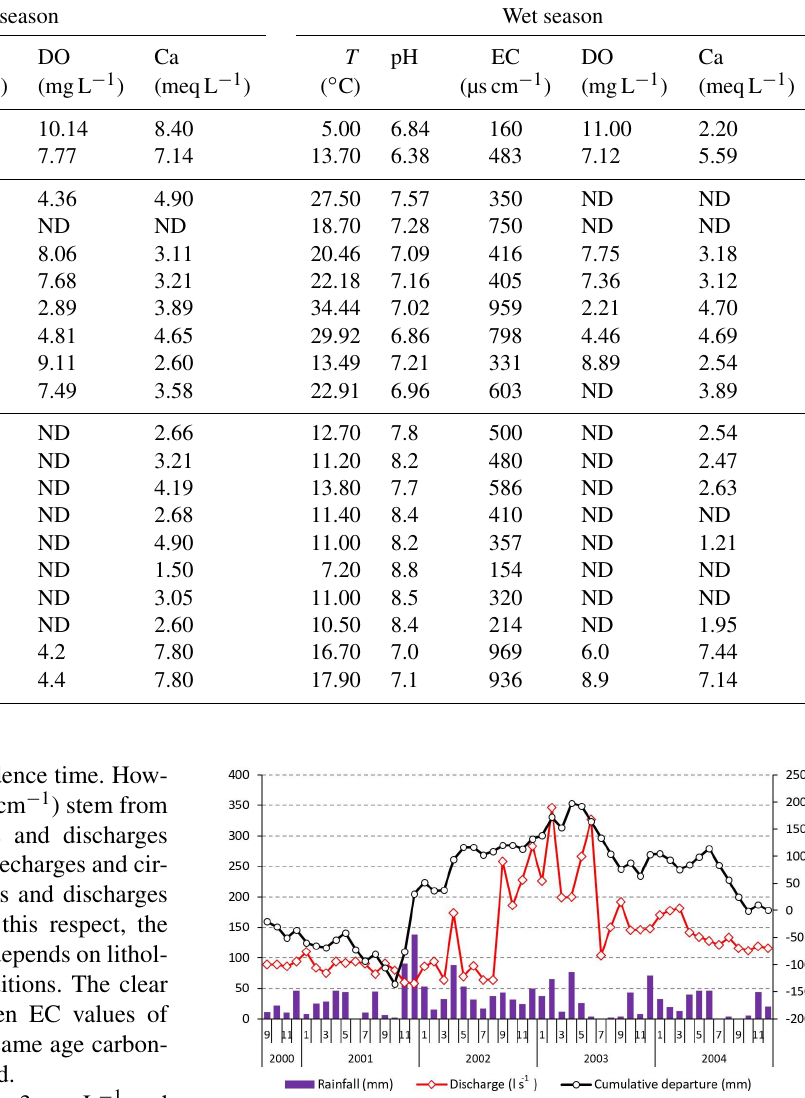
Figure 6. Hyetograph, hydrograph and cumulative departure of the Suba¸sı spring (S8) (vertical axis on the left is used for both rainfall and discharge, vertical axis on the right for cumulative departure